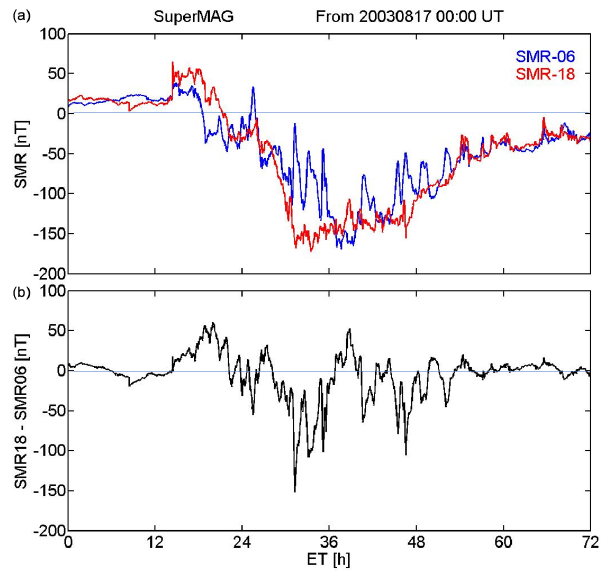
Figure 9. (a) Temporal evolution of the SMR storm-time index from the 06:00 and 18:00 local time sectors. (b) Differences be- tween the two time sectors (SMR-06 −